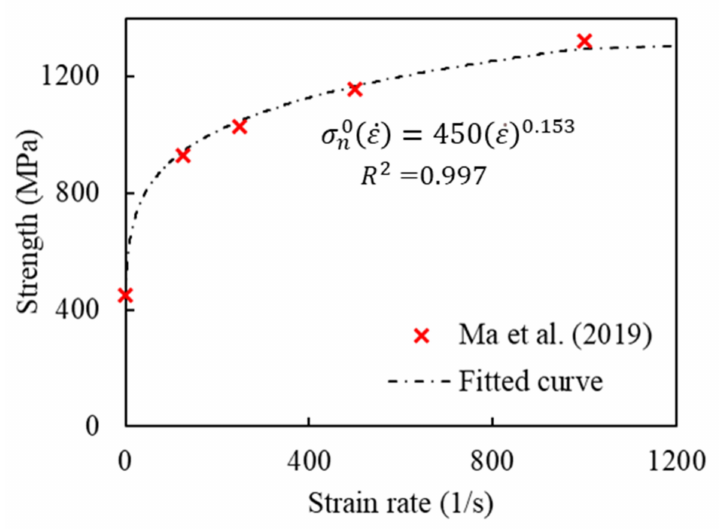
Figure 3. Strain-rate-dependent normal strength estimation for glass fibre woven composites com- pared with the data from mesoscale RVE simulations of Ma et al. [38]. Drawn on the basis of the data from [38].